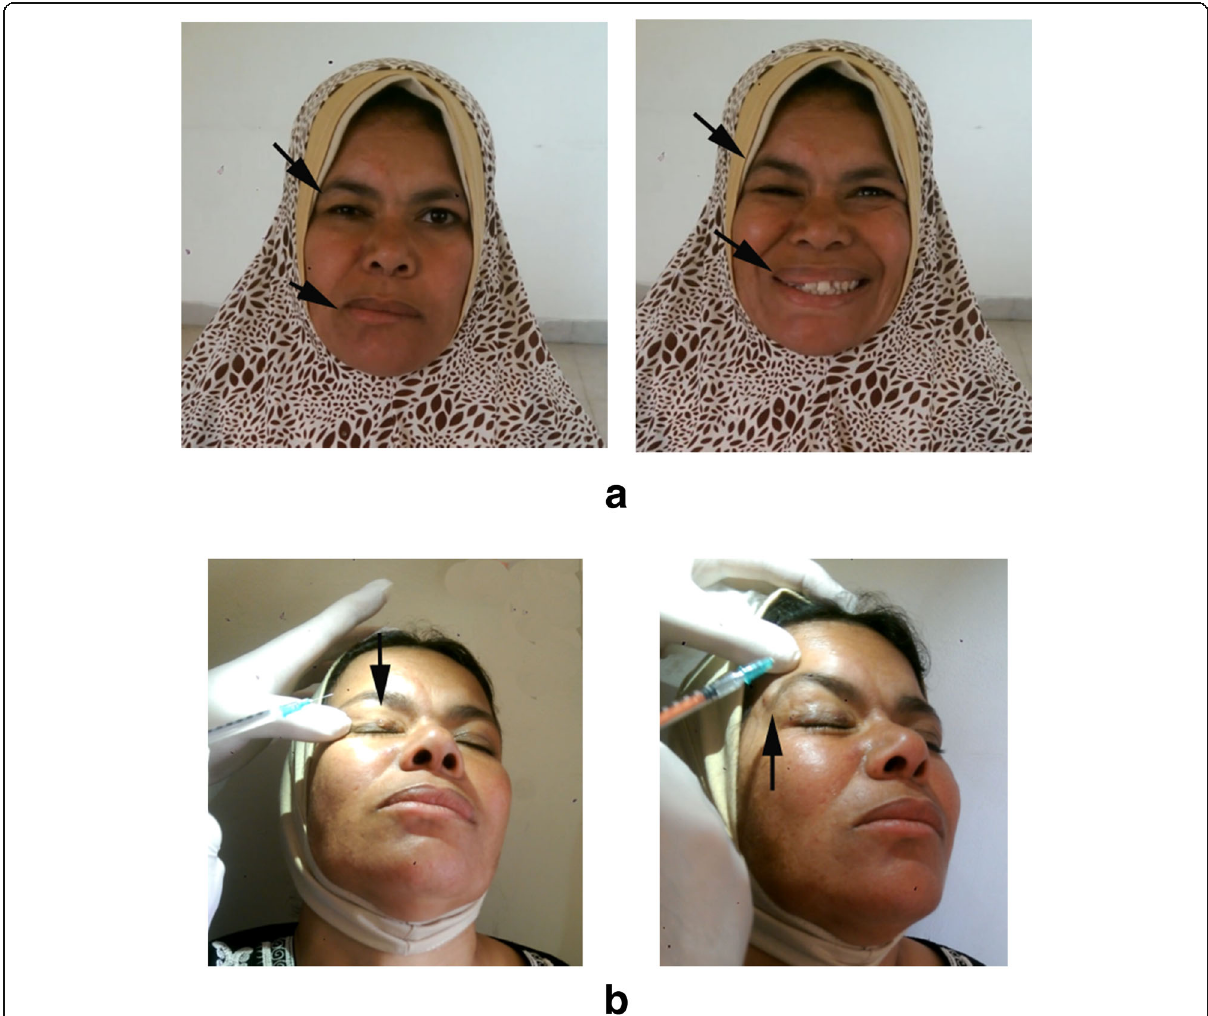
Fig. 2 A case of hemifacial spasm treated with Botox injection. a Pre-procedure status: spasm in orbicularis occuli is noted. b Botox injection procedure. c Early post procedure status: weakness in orbicularis occuli was noted. d During follow up: improvement of orbicularis occuli